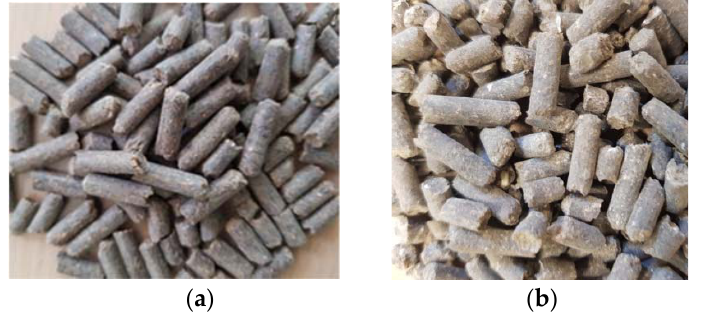
Figure 1. Granular organic particles based on poultry manure: ( a ) granules with a diameter of 6 mm; ( b ) granules with a diameter of 4 mm.